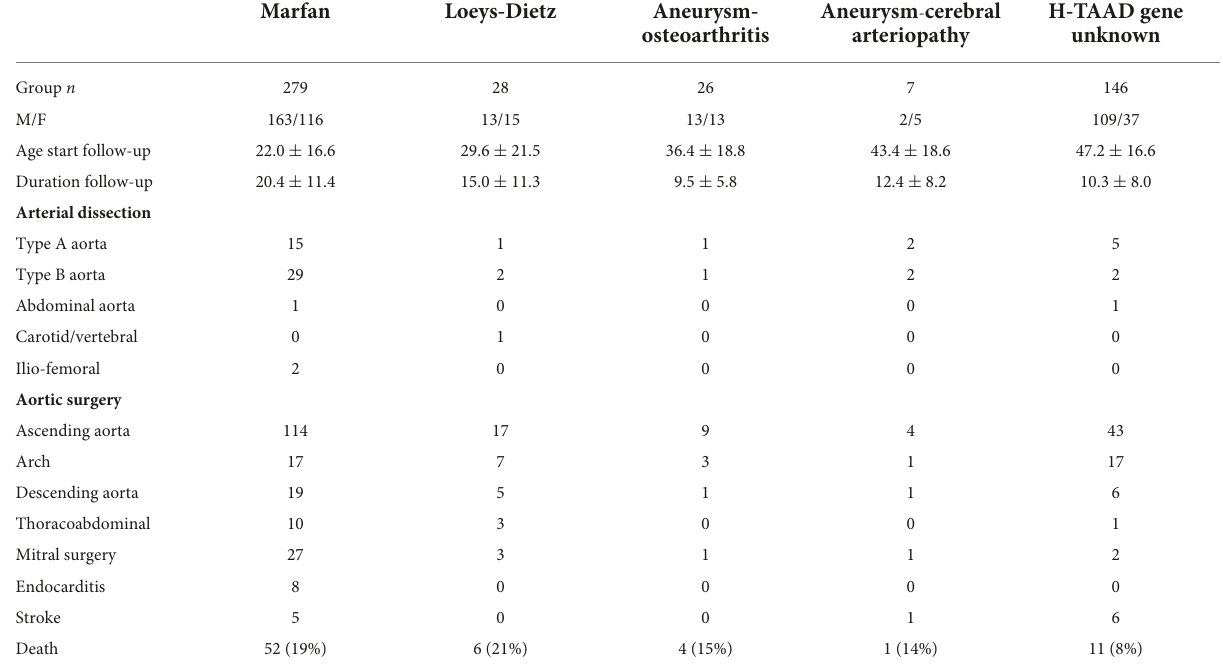
TABLE 2 Clinical outcomes during